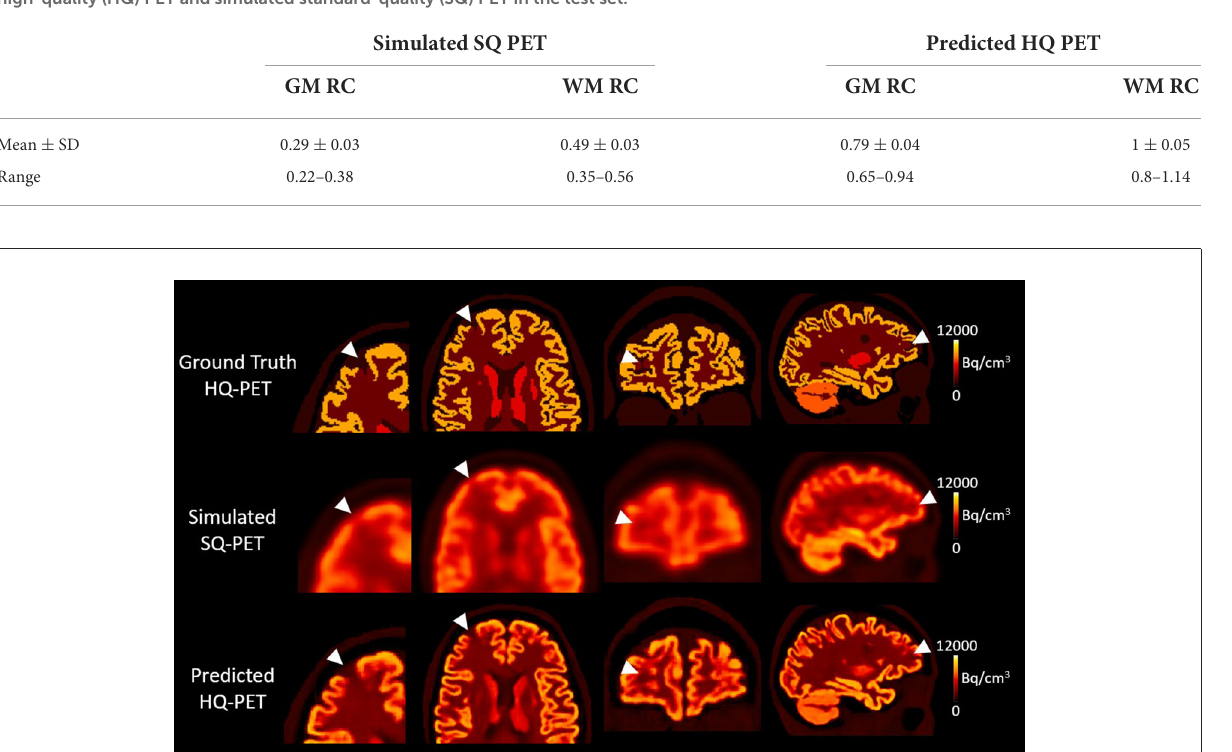
(1 non-diagnostic, 2 =